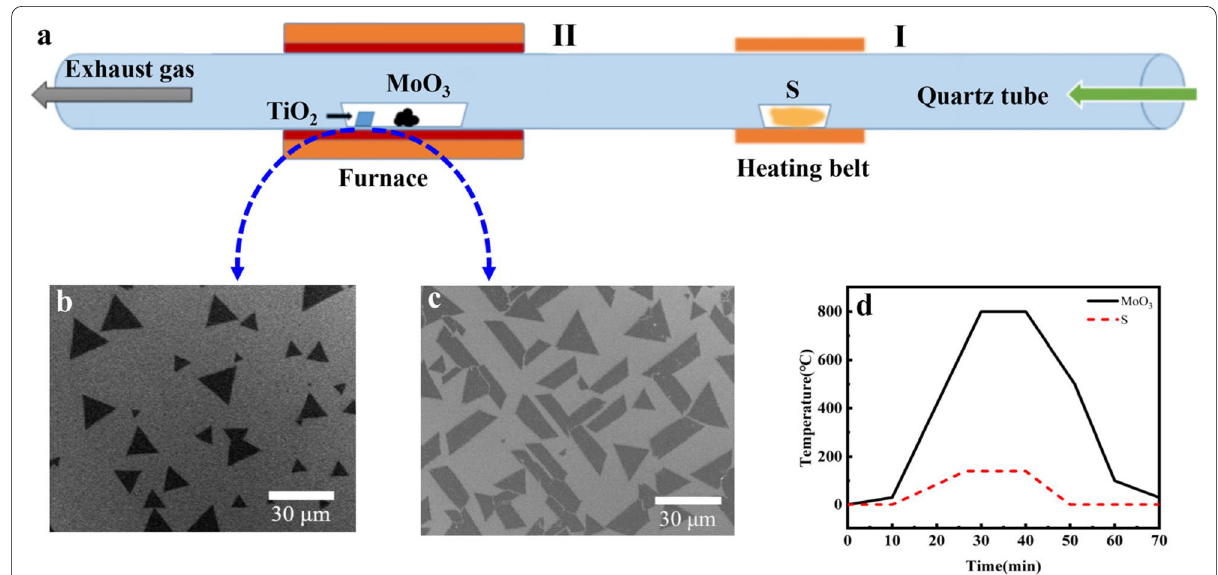
Fig. 1 a A set of the CVD system with two temperature zones, I and II. b , c SEM images of ML MoS 2 patterns on rutile-TiO 2 (001) substrate with triangular and belt-like shapes, respectively. d The temperature curve of MoO 3 and S are set during the growth of the belt-like ML MoS